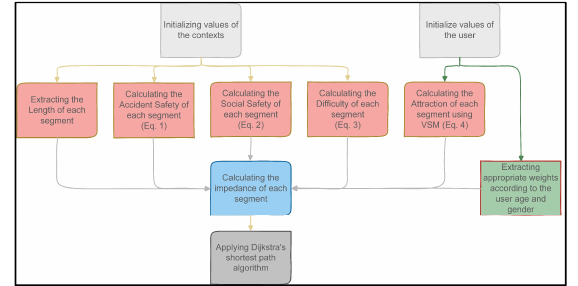
Figure 2. Steps of the proposed ubiquitous pedestrian wayfinding